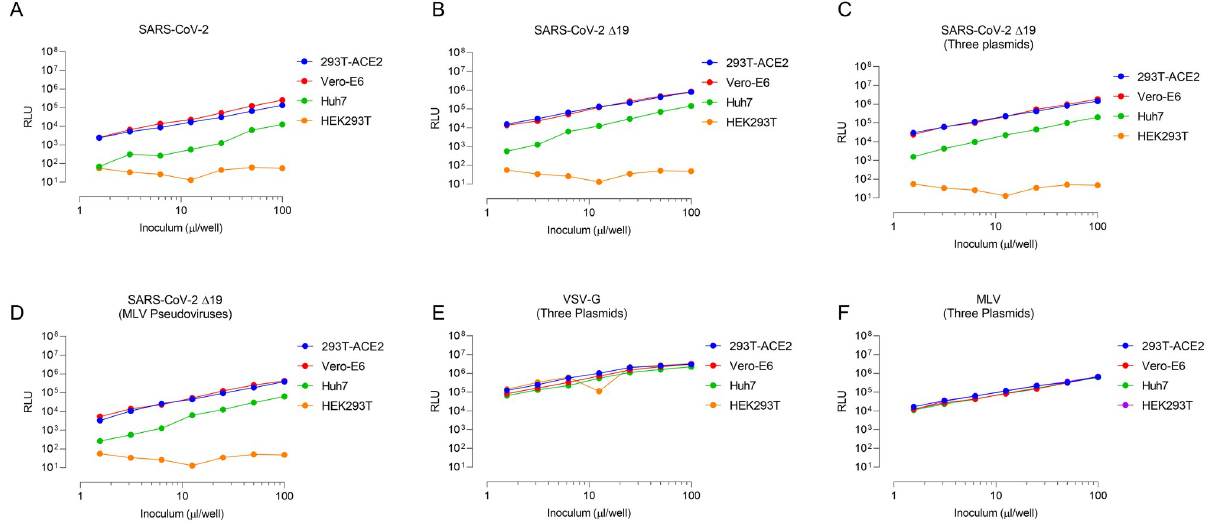
Fig 3. Lentiviral (HIV-1) particles pseudotyped with SARS-CoV-2 spike productively infect 293T/ACE2 and Vero-E6 cells. (A–D) Infectivity measurements of SARS-CoV-2 pseudoviruses on the indicated cell lines. Infectivity was quantified by measuring luciferase activity (relative light units, RLU) following infection of cells in 96-well plates with the indicated volume (inoculum, μ l/well) of pseudotyped viruses. Pseudoviruses were generated by using two plasmid system (HIV-1 proviral backbone containing luciferase gene and SARS-CoV-2 spike) or three plasmid system (HIV-1 proviral backbone, Luciferase reporter plasmid and SARS-CoV-2 spike). Infectivity assays were performed twice in triplicates and average RLU are shown. (E– F) Amphoteric VSV-G and MLV pseudoviruses were used as positive virus infection controls.